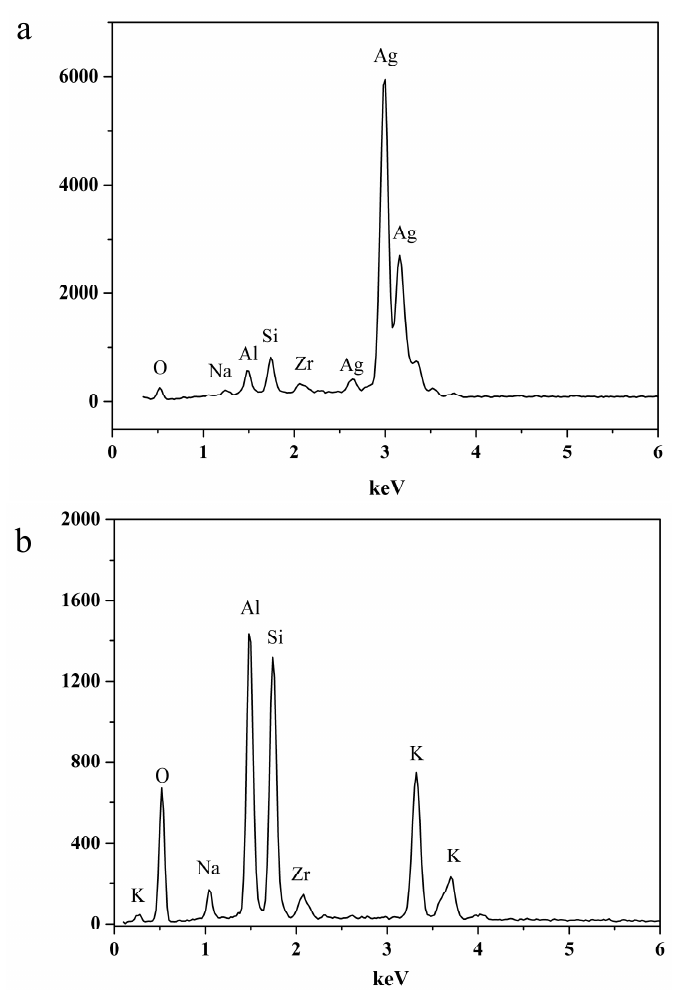
Figure 9. Energy-dispersive X-ray spectrometry (EDX) analysis for different cation-treated NaA zeolite membranes ( a ) AgNO 3 solution treatment, ( b ) KCl solution treatment.